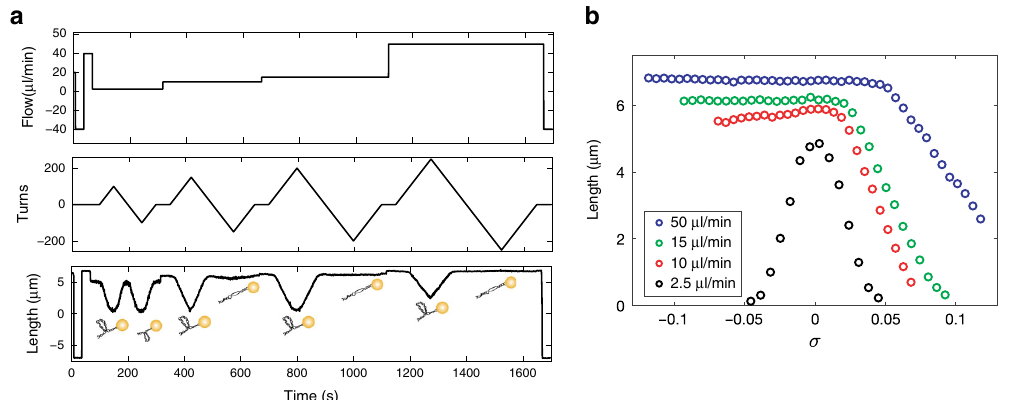
Fig. 2 Force dependence of length for supercoiled DNA demonstrated by FMT. a Changes in length are displayed for positive and negative supercoiling states at four fl ow rates. Negatively supercoiled DNA only compacts at the lowest fl ow rate, which corresponds to a force below 1 pN. The height of the magnets is held constant. b The mean length as a function of turns and force for a single molecule displays an asymmetric character, where positive buckling is less sensitive to increases in fl owrate than negative